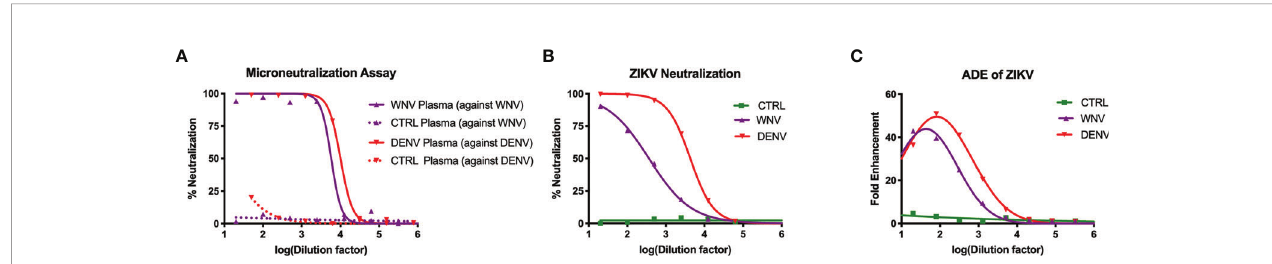
FIGURE 1 | Neutralization and enhancement potential of WNV immune plasma. (A) The capacity of plasma from WNV-infected individuals to neutralize WNV (Kunjin isolate) was compared to the capacity of plasma from DENV-infected individuals to neutralize DENV (serotype 1) in Vero cells. Non-reactive CTRL plasma was used as a negative control for each. Neutralization is represented by the percent reduction in infection compared to virus alone. (B) Neutralization of ZIKV (strain PRVABC- 59) by WNV, DENV, and CTRL immune plasma in Vero cells is shown. (C) Enhancement of ZIKV by WNV, DENV, and CTRL immune plasma was tested in K562 cells. Enhancement was determined based on percent infection over the virus alone condition. All assays were completed in technical